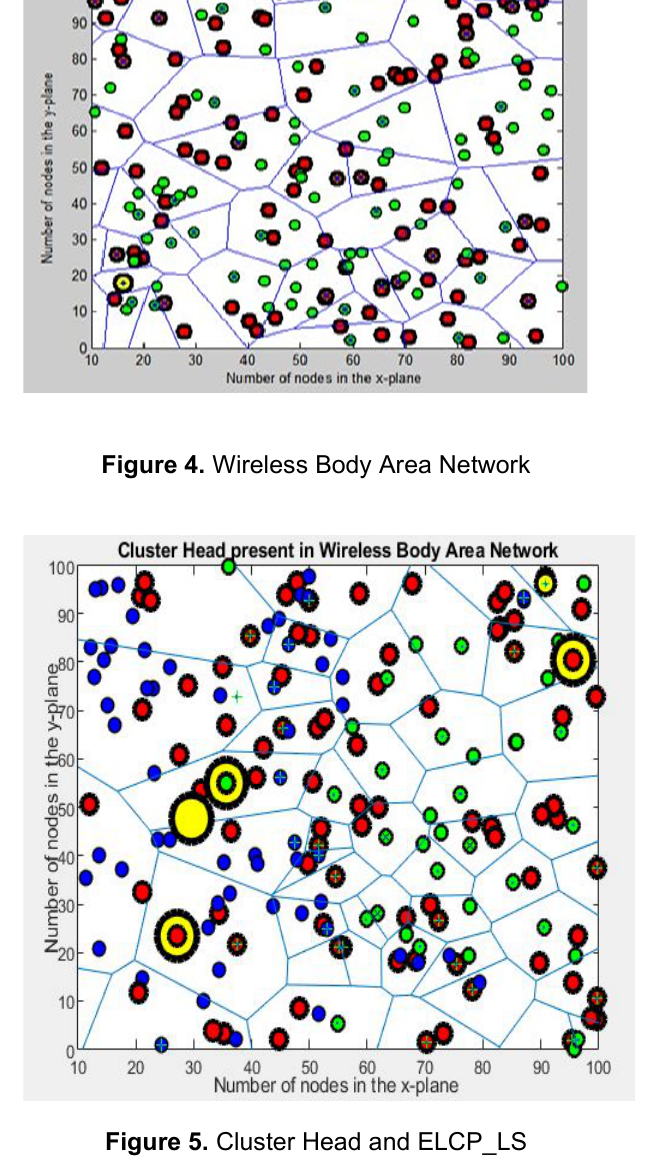
Figure 5. Cluster Head and ELCP_LS